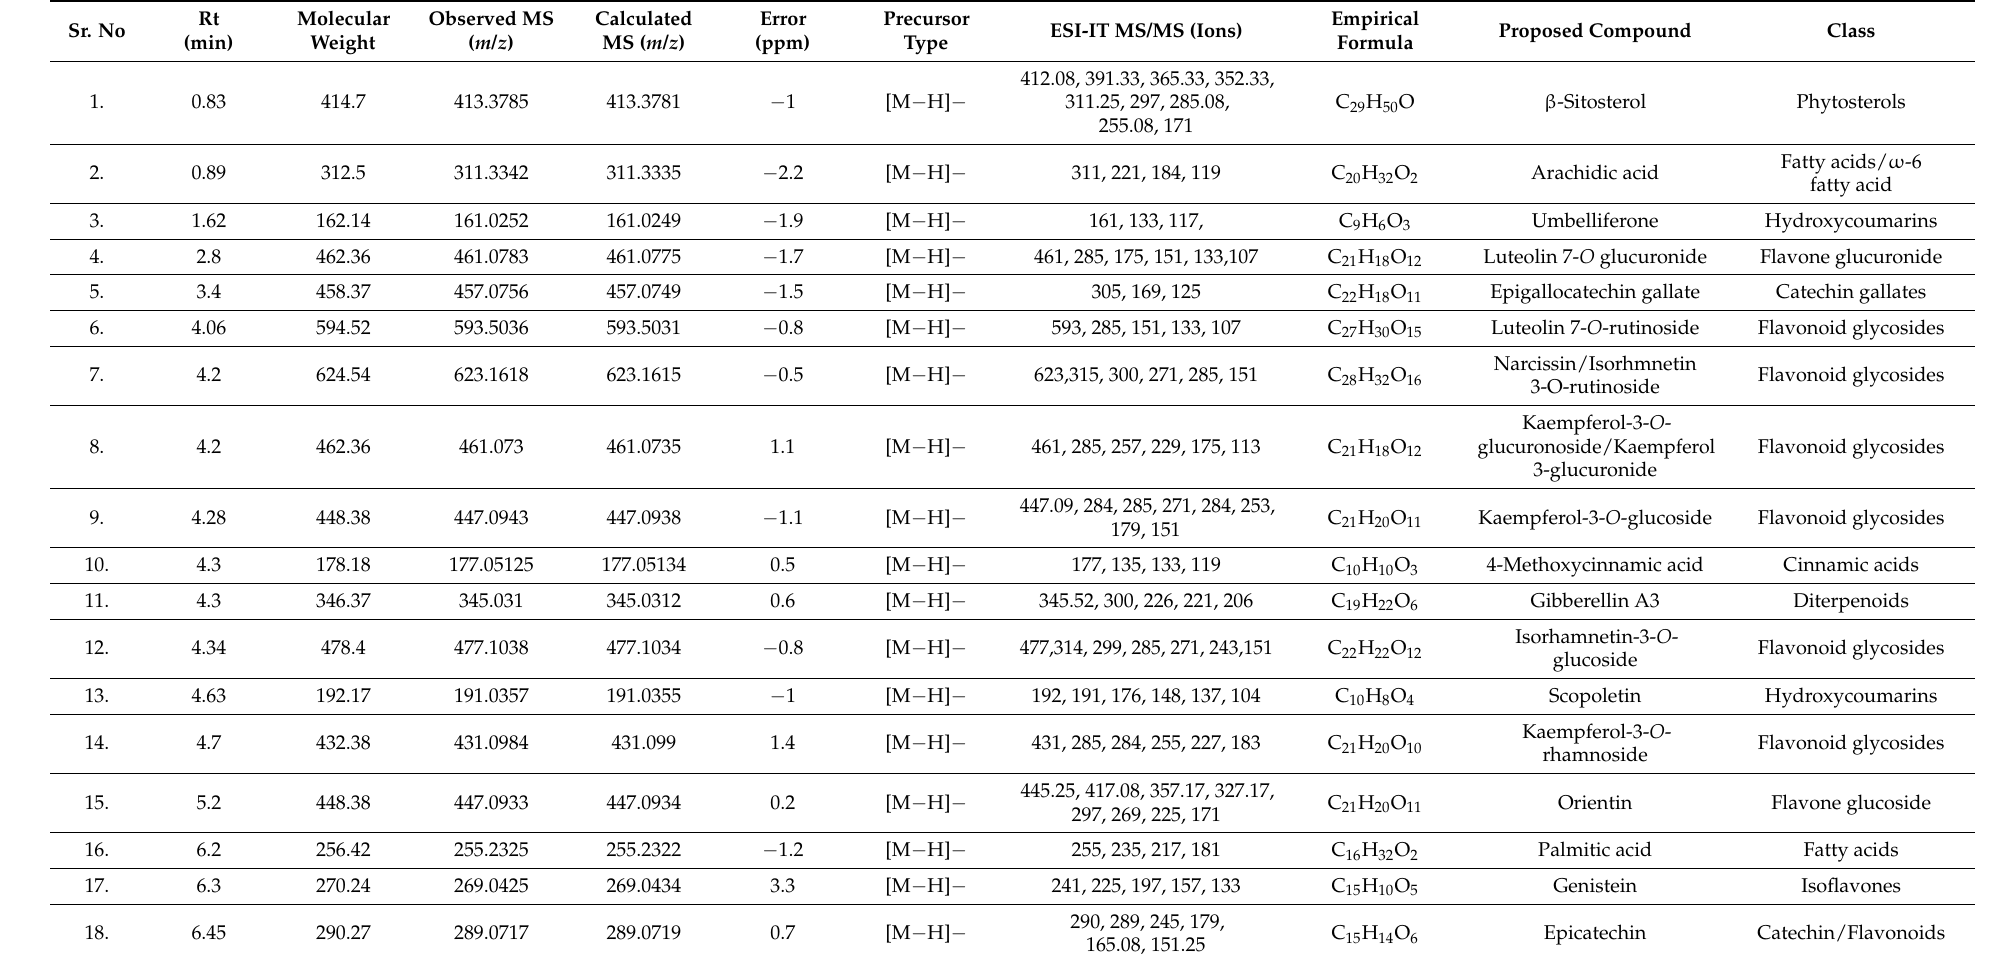
Table 1. Identification of compounds in the hydroethanolic extract of Cucumis sativus